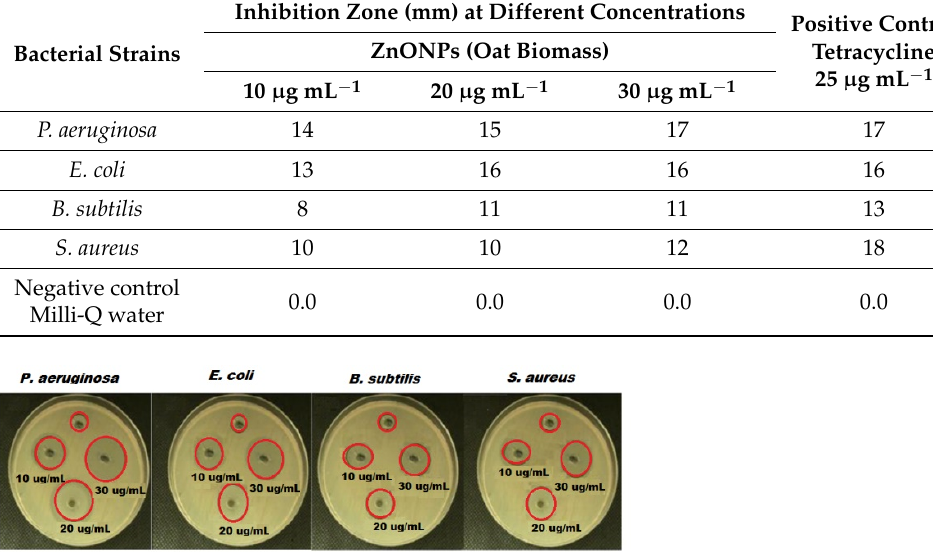
Table 1. Antibacterial effect of ZnONPs synthesized using oat biomass on four different bacterial strains. Inhibition Zone (mm) at Different Concentrations Bacterial Strains